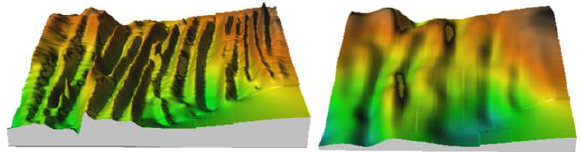
Figure 6. Tension and Smoothing parameters effect on elevation model left image 40 tension and 0 smoothing right image 10 tension and 10 smoothing